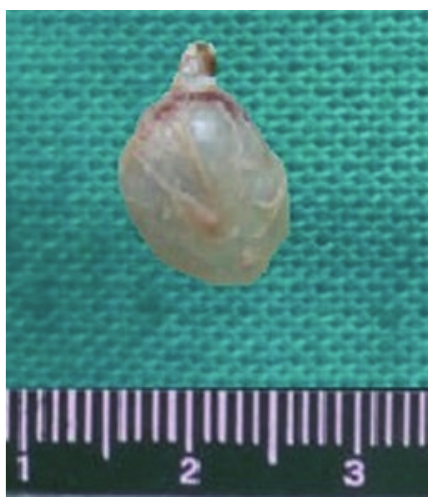
Figure 2: Gross morphology: cystic mass.